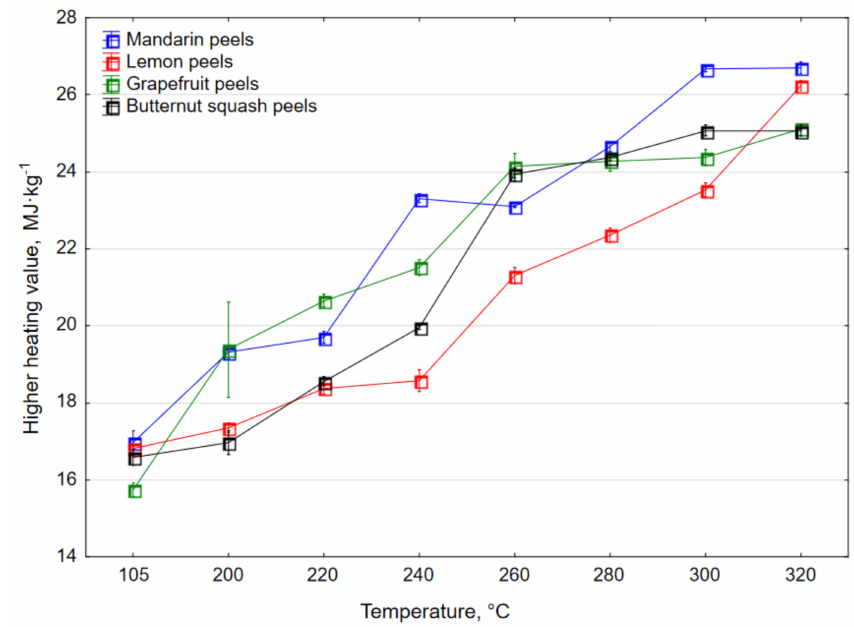
Figure 5. Higher heating value of the torrefied waste